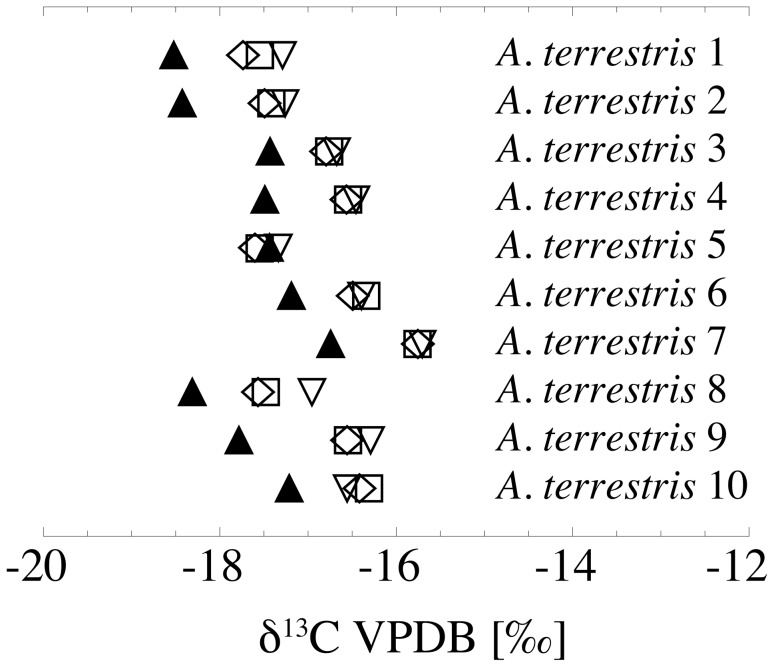
Intra-jaw variations in δ13C of Arvicola terrestris.Filled triangles = incisors, open diamonds = M1, open squares = M2, open down triangles = M3.